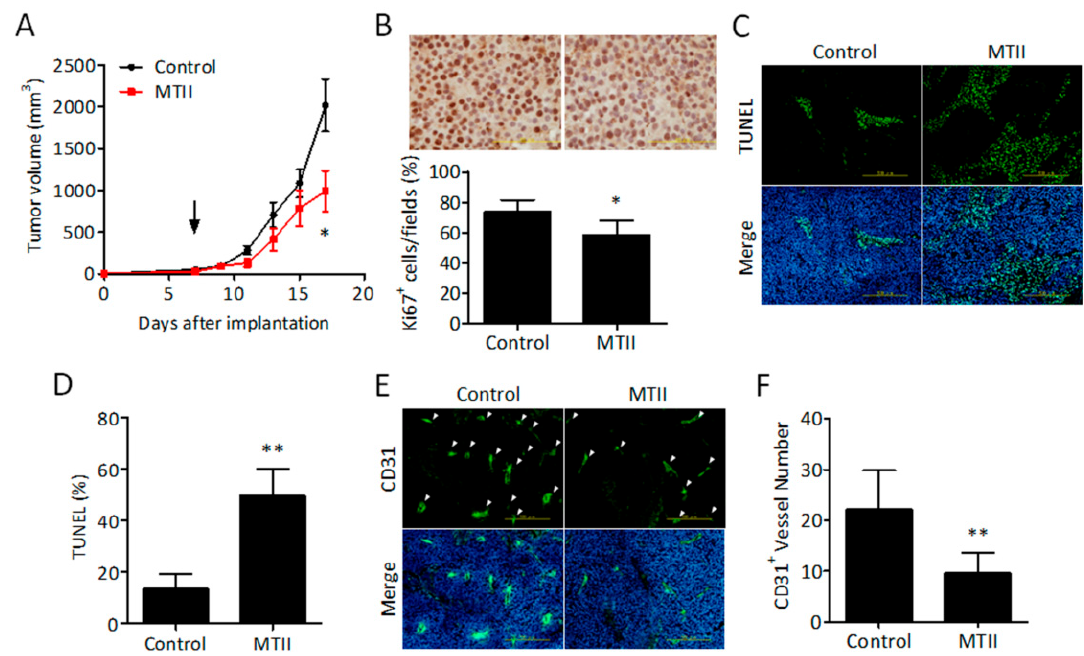
Figure 2. Effect of topical MTII administration on tumor growth in established primary melanoma model. ( A ) Mice were implanted with B16-F10 melanoma cells at Day 0. After the tumor size in each mouse was at least 100 mm 3 at Day 10, mice were randomly divided into two groups ( n = 6) and treated with MTII peptide topically once daily for 14 days. The tumor volume was measured by caliper once every two days and presented as the mean ± SEM. The arrow indicates the date of topical MTII treatment. ( B ) The representative images of Ki67 expression in the control and MTII-treated melanoma tissues. The bar chart shows the proliferation index of Ki67 nucleus positive cells in tumor tissues ( n = 6 / each group). Scale bar, 200 µ m. ( C ) Representative profiles of TUNEL staining in control and MTII-treated melanoma tissues. DAPI (blue) was used as a nuclear counterstain. Scale bar, 500 µ m. ( D ) The apoptotic cells in melanoma tissues are expressed as a percentage of the number of TUNEL positive cells over the number of TUNEL positive cells. Data are expressed as the mean ± SD from 6 experiments. ( E ) Representative profiles of CD31 staining in control and MTII-treated melanoma tissues. Scale bar, 500 μ m. ( F ) The amounts of CD31 + vessels were counted from different melanoma tissues ( n = 6). *: p < 0.05, **: p < 0.01.